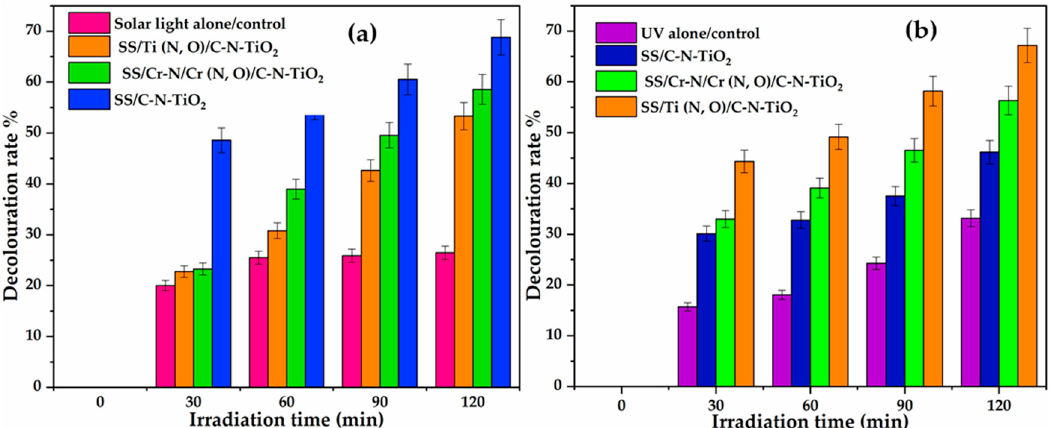
Figure 6. Photocatalytic performance of SS and anticorrosion coatings coated with C-N-TiO 2 nano composites for the decolouration of orange II (O.II) dye under solar light ( a ) and UV light ( b ). Experimental conditions: Dye concentration 10 mg/L, pH 2.5, volume 500 mL, Mega-Ray 160 W/240 V MR160 UV lamp, and an irradiation time of 120 min (n = 3).